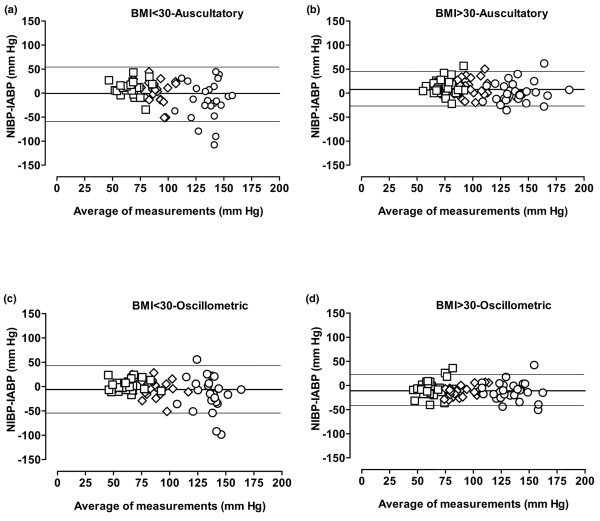
Agreement between auscultatory and oscillometric, and intra-arterial blood pressure measurements: effect of BMI. Shown are graphs of measurement in (a) overweight (BMI ≤30 kg/m2) (b) obese (BMI >30 kg/m2) patients by auscultatory technique, and (c) overweight and (d) obese patients by oscillometric technique. The thicker line represents mean bias, and the thinner lines represent upper and lower limits of agreement. Squares are diastolic blood pressure measurement, diamonds are mean arterial blood pressure measurements, and circles are systolic blood pressure measurements. BMI, body mass index; IABP, intra-arterial blood pressure; NIBP, noninvasive blood pressure.